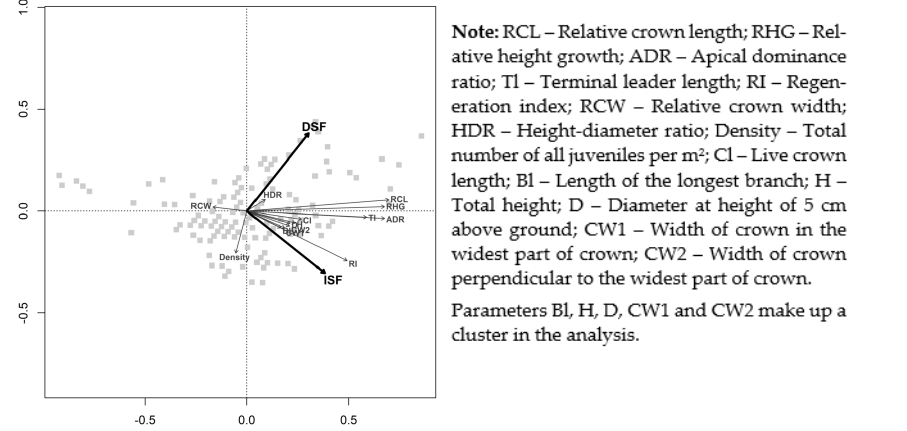
Figure 3. The results of redundancy analysis (RDA) where two factors were involved — indirect site factor (ISF) and direct site factor (DSF).